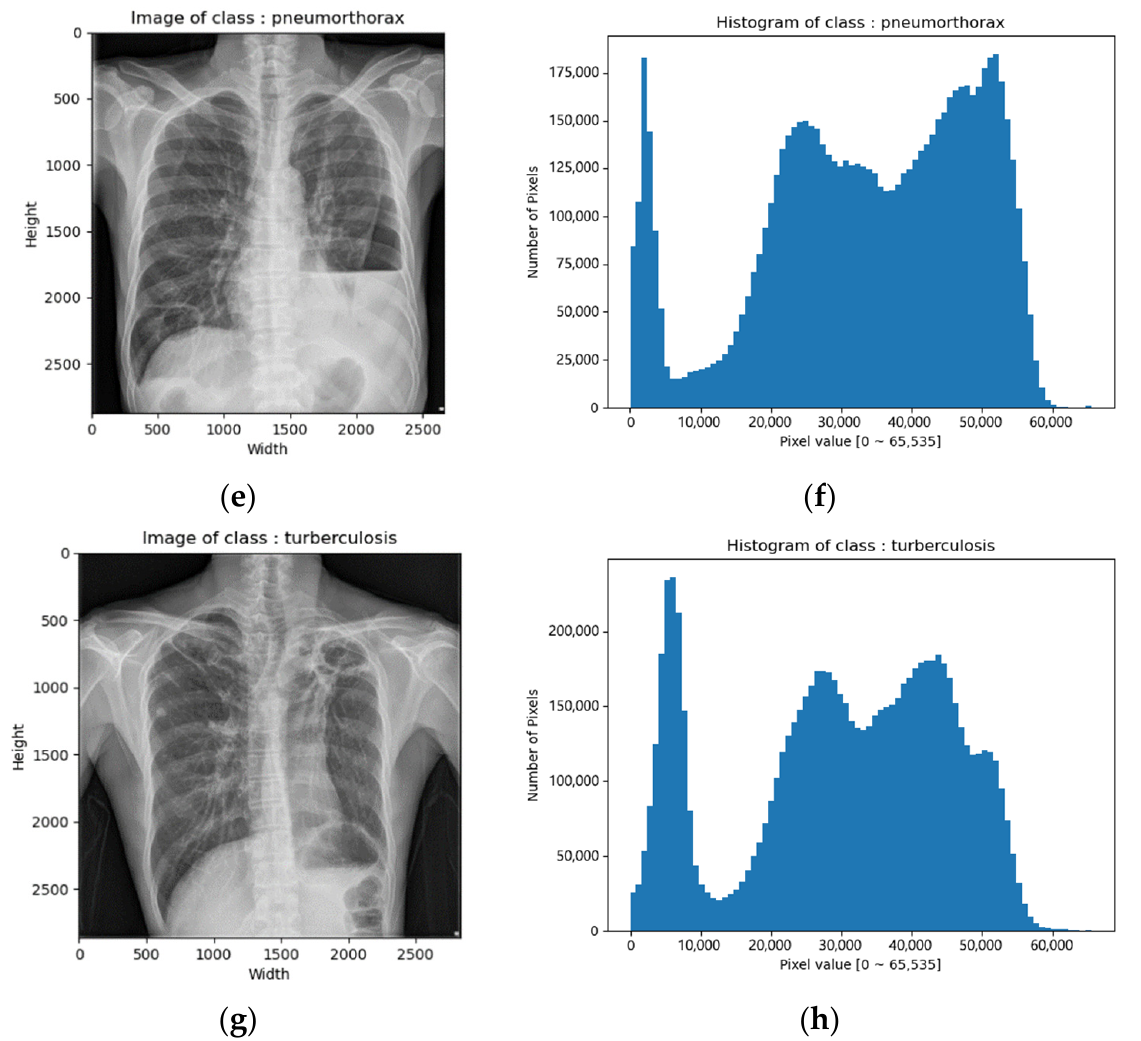
Figure 2. CXR images of SCH data set: ( a ) image of normal class; ( b ) histogram of normal class; ( c ) image of pneumonia class; ( d ) histogram of pneumonia class; ( e ) image of pneumothorax class; ( f ) histogram of pneumothorax class; ( g ) image of tuberculosis class; ( h ) histogram of tuberculosis class.